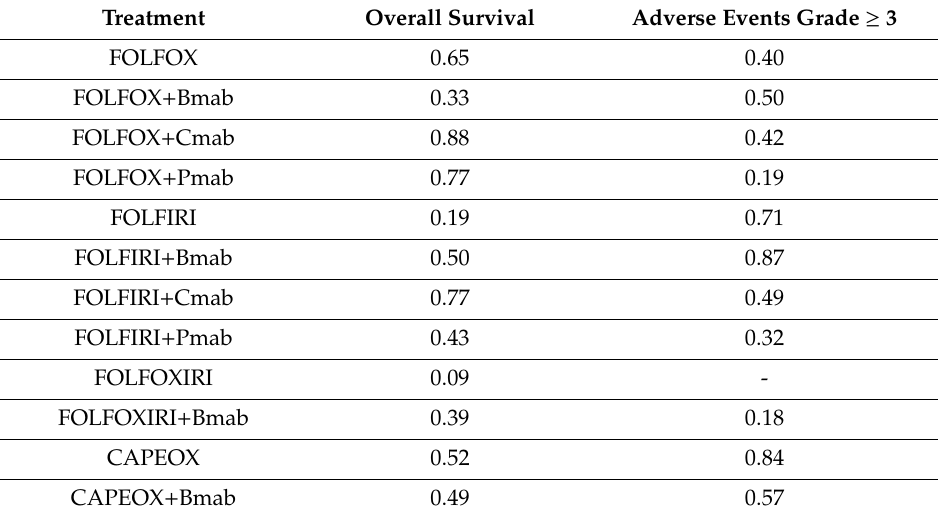
Table 7. SUCRA value for treatment